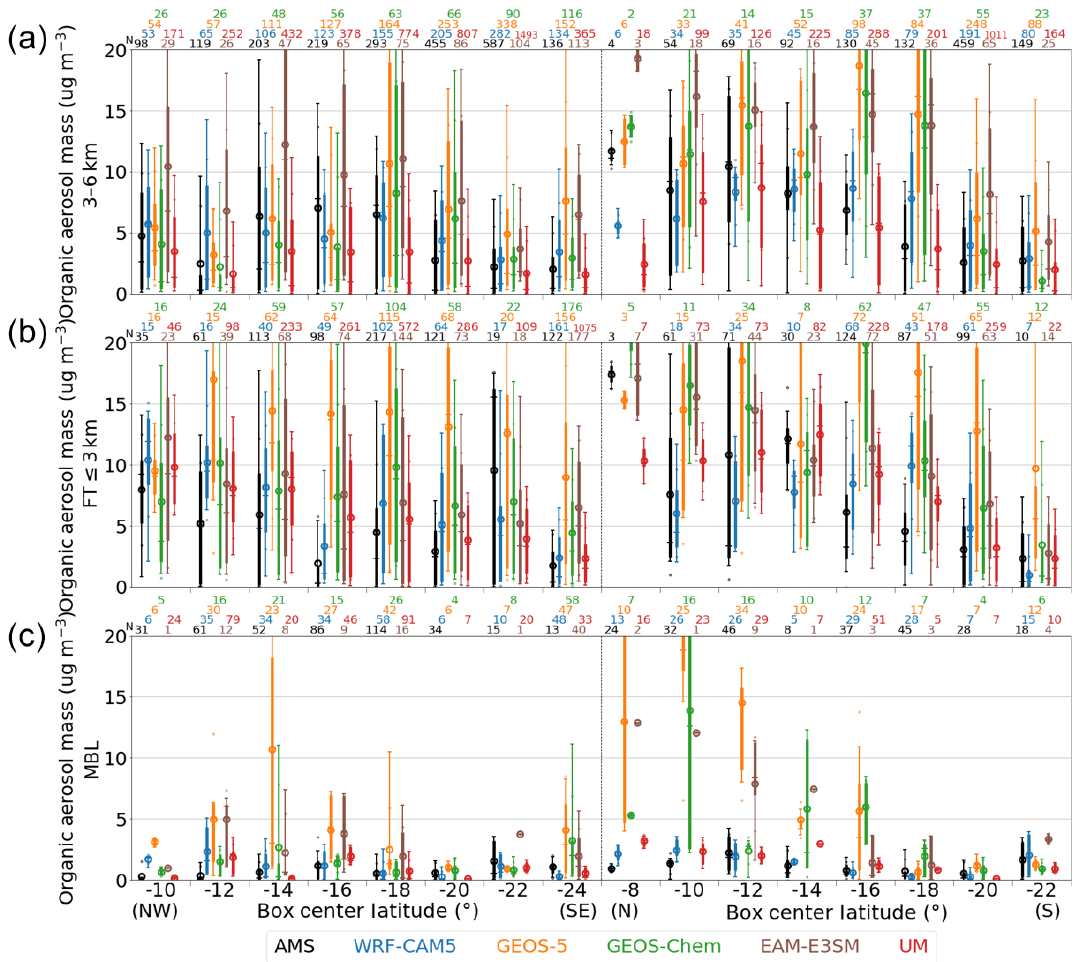
Figure 7. Same as Fig. 6 but for organic aerosol mass. The range of vertical axis is chosen for clarity. The GEOS-5 mean values in two boxes exceed the